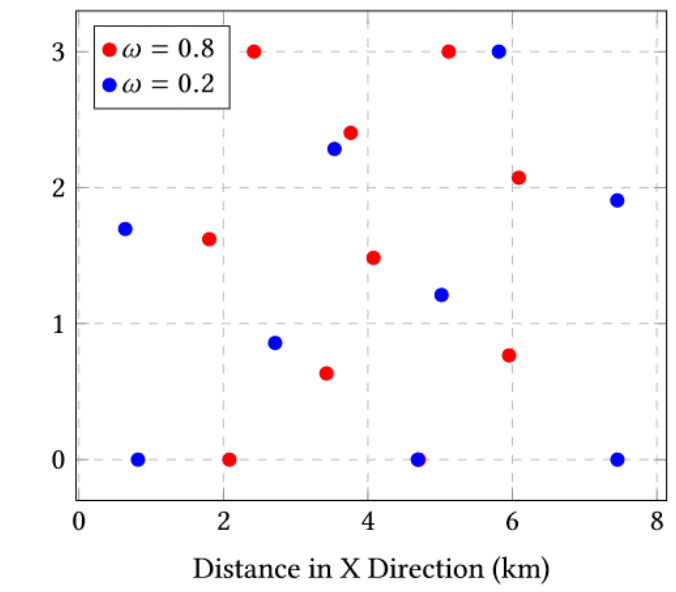
Figure 5. Final positions for ω = 0.8 and ω = 0.2 for the case of 10 sensors.